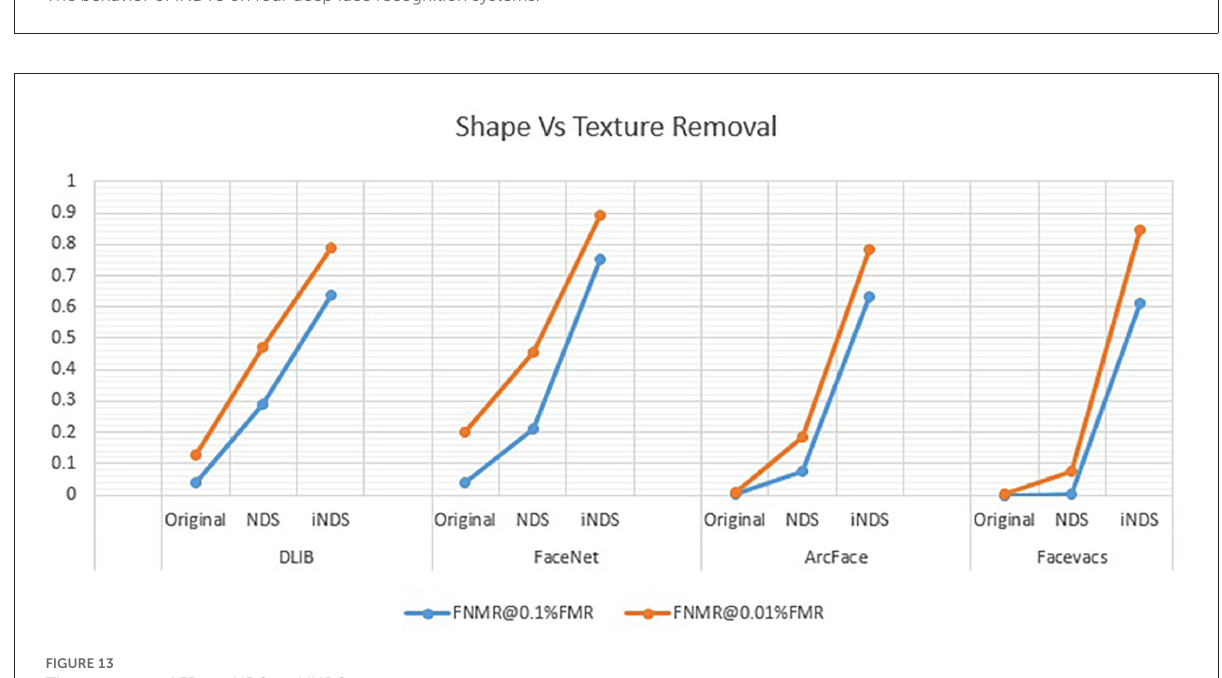
FIGURE12 The behavior of iNDTS on four deep face recognition systems.